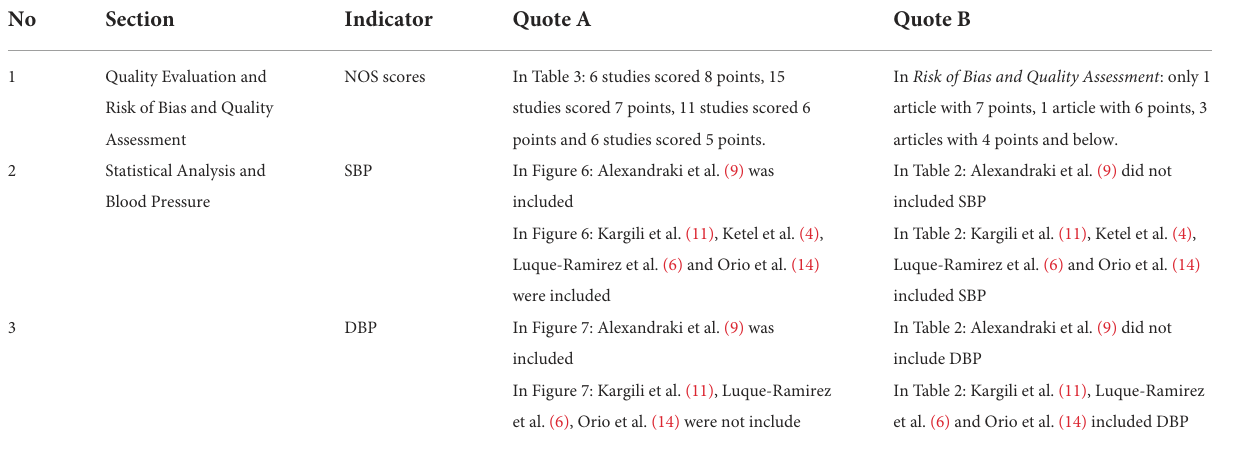
TABLE 2 Inconsistent information in the original review.